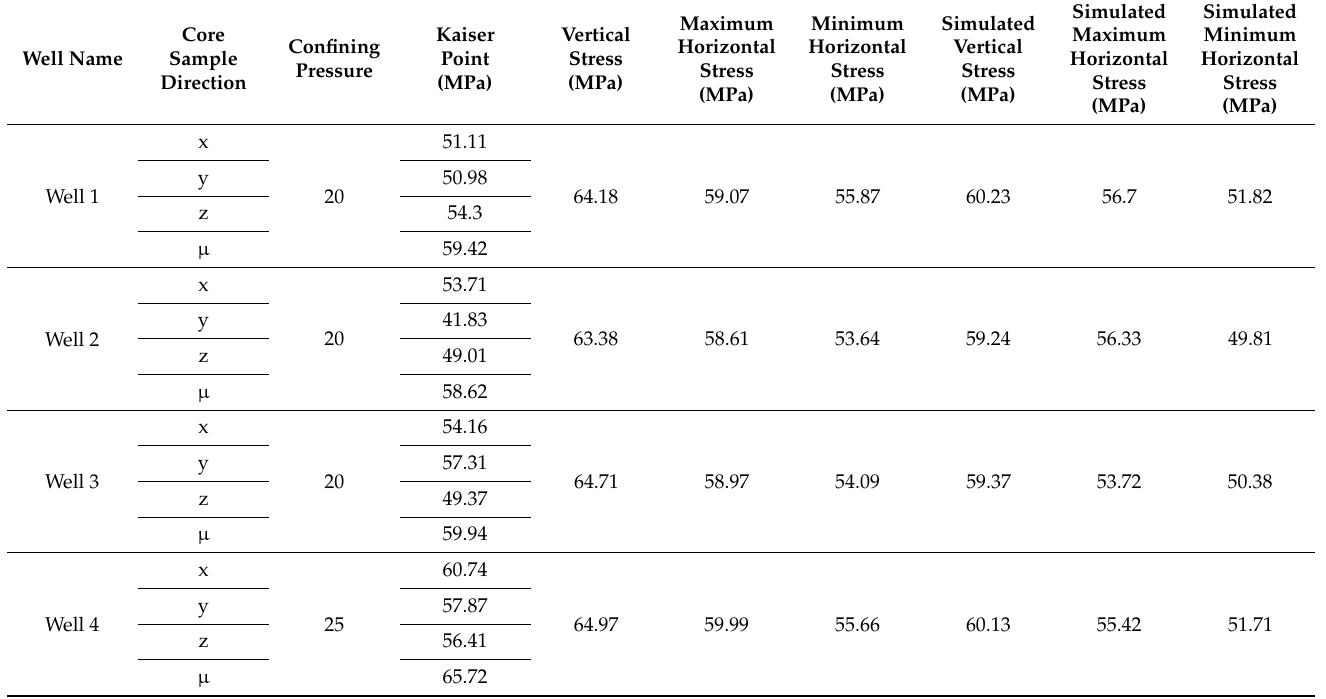
Table 1. The simulated and test tectonic stress values or the target